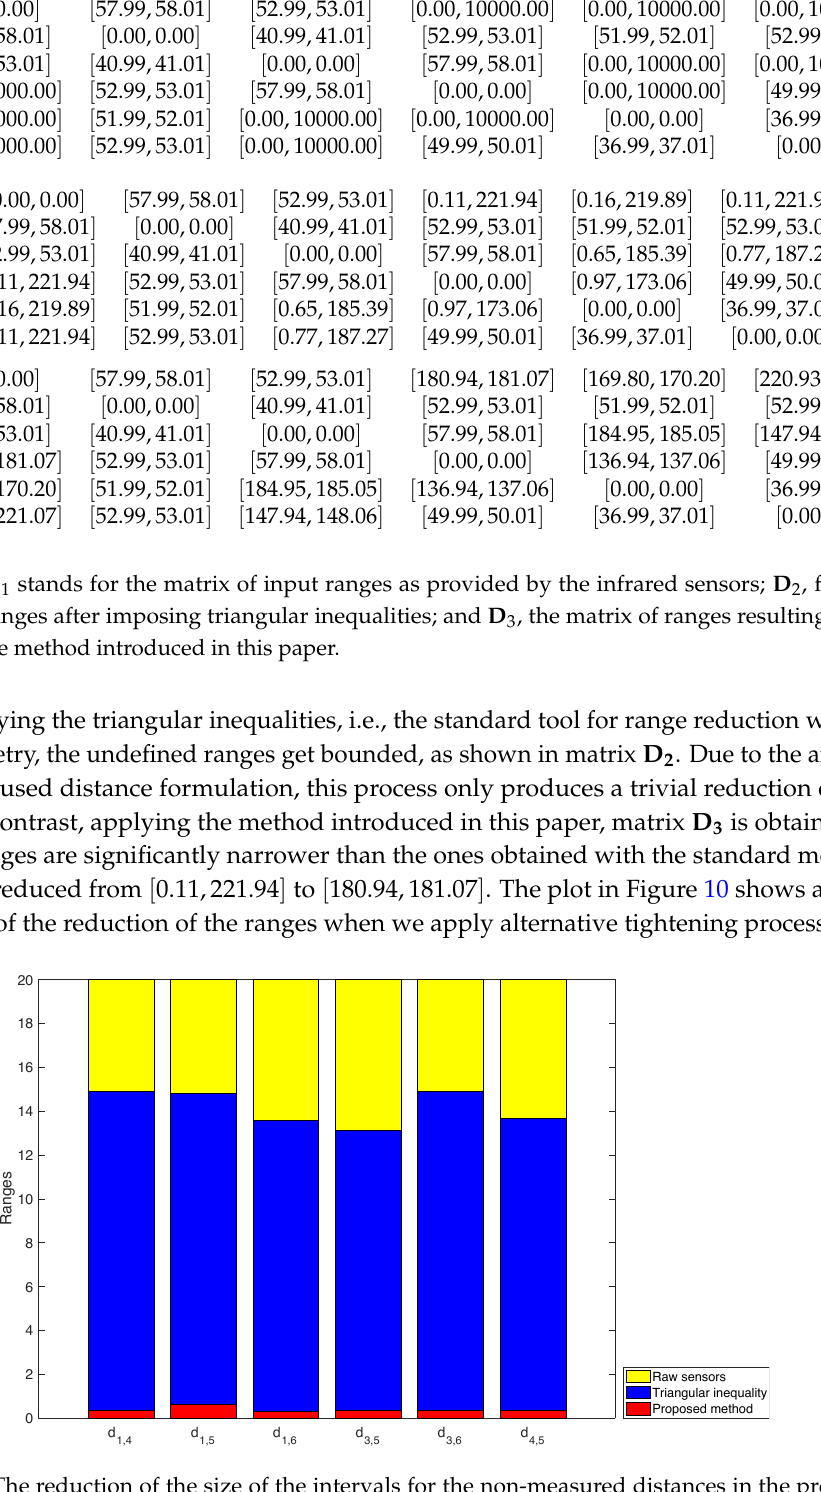
Figure 10. The reduction of the size of the intervals for the non-measured distances in the problem when applying alternative tightening